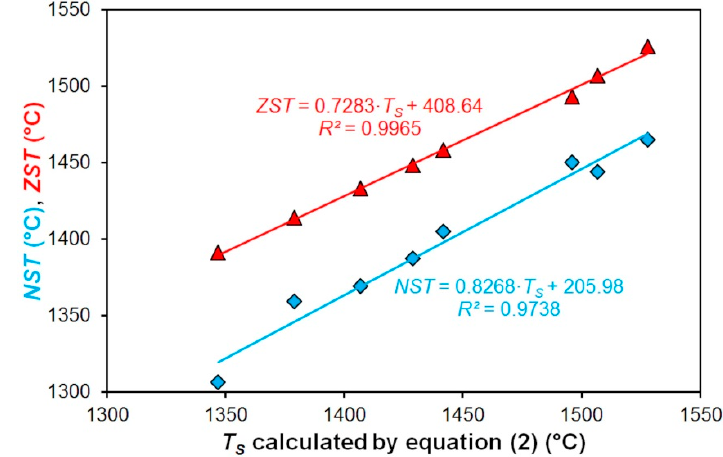
Figure 6. Dependence of the measured nil-strength temperature and the calculated zero strength temperature on the solidus temperature of the investigated steels. Table 5. Evaluation of accuracy of Equations (6) and (9) intended for the calculation of the nil-strength temperatures of the investigated steels.